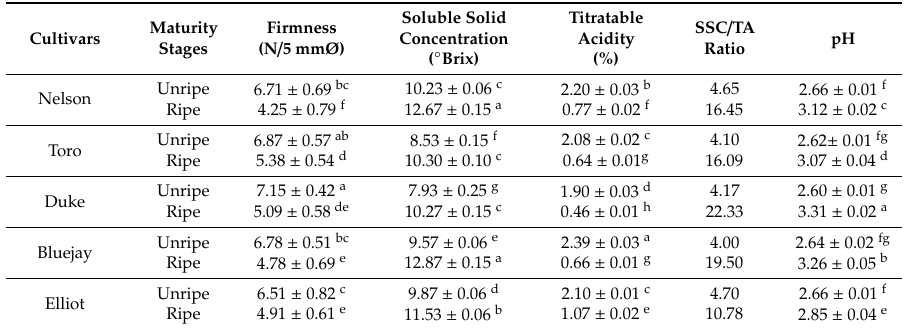
Table 2. Firmness, Soluble solid content, titratable acidity, and pH of blueberry fruits at di ff erent maturity